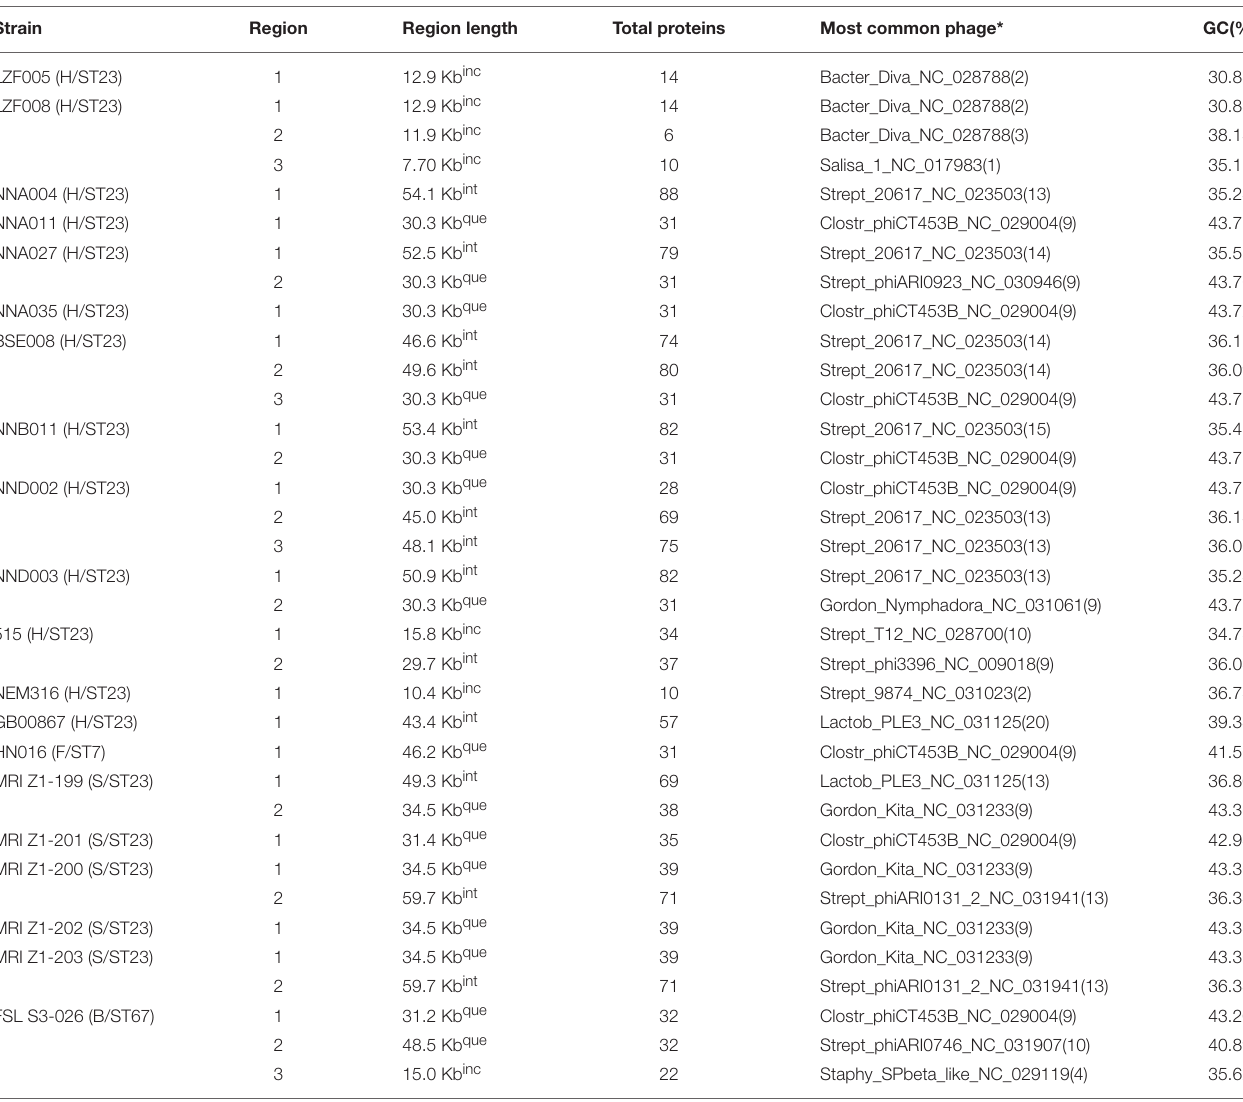
TABLE 1 | The analysis of prophage from GBS strains. Strain Region Region length Total proteins Most common phage*